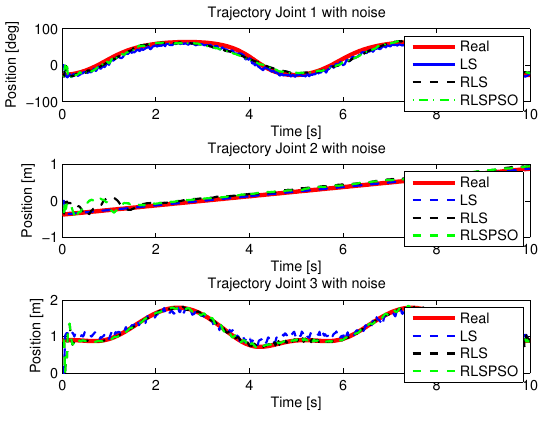
Figure 42. Trajectories with noise identifications.